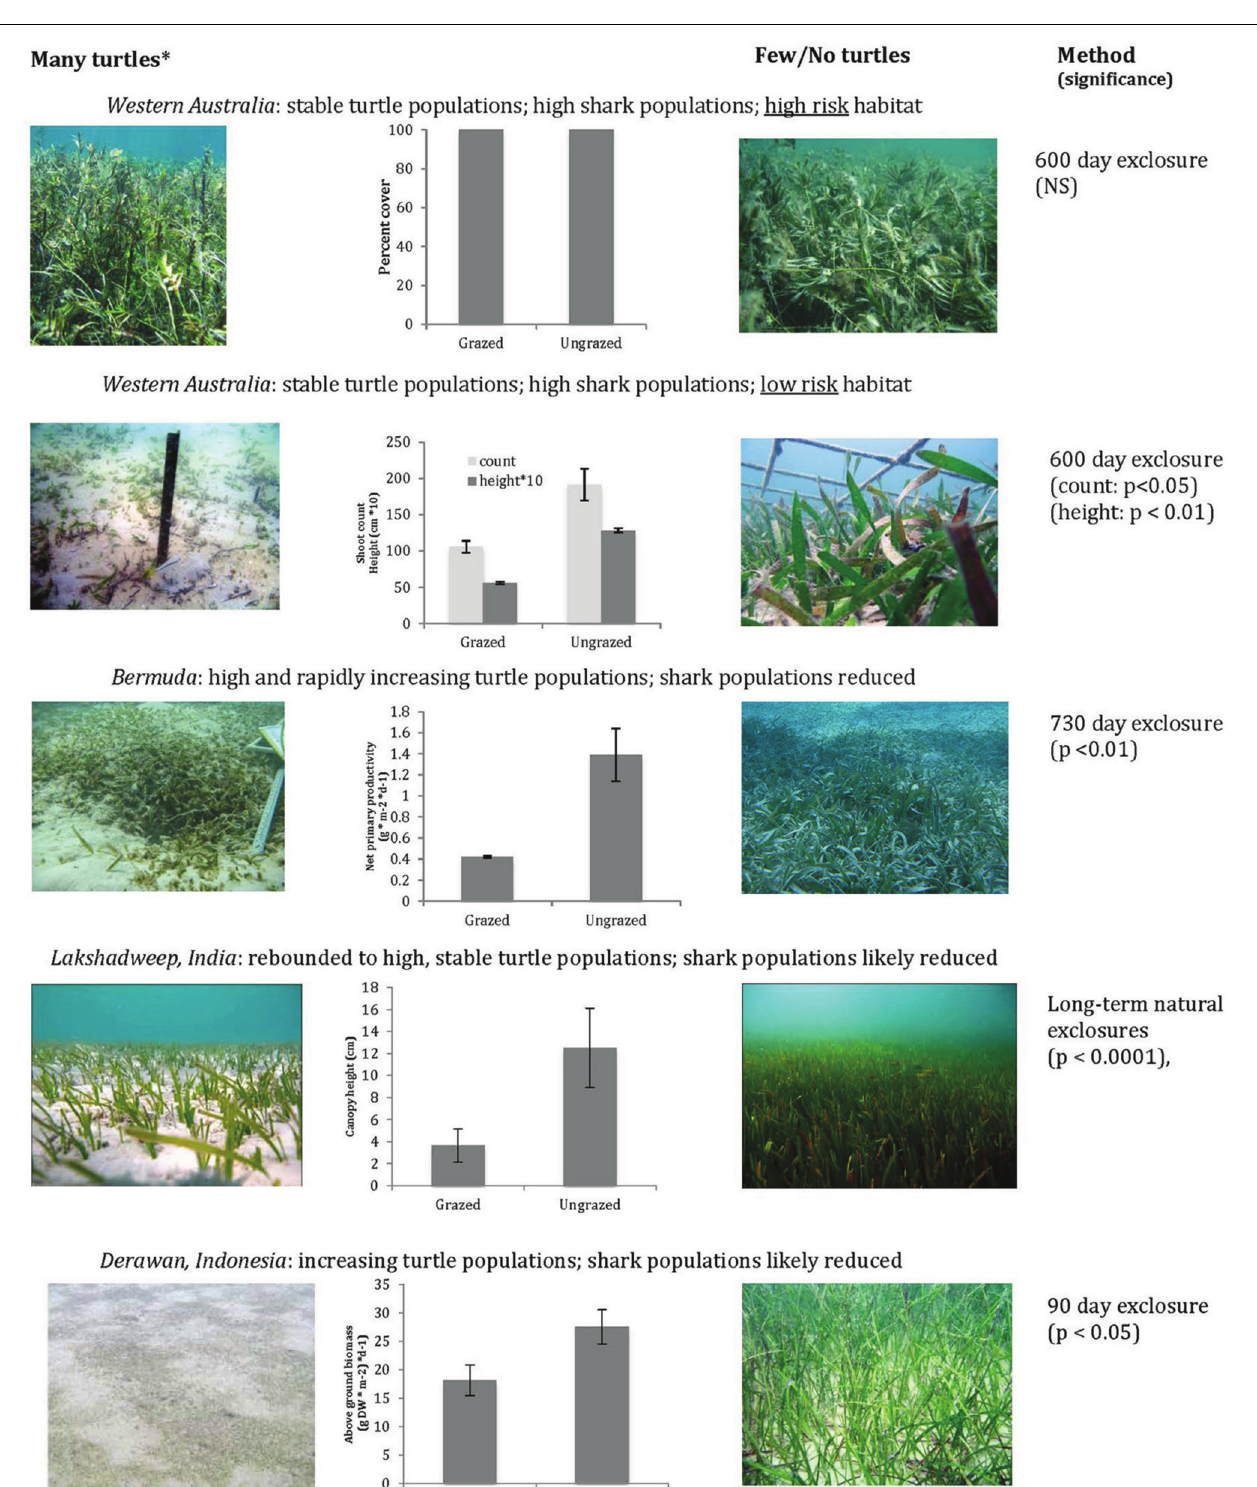
FIGURE 1 | Responses of seagrasses to green turtle grazing across ecological contexts. Although individual studies measured multiple responses of seagrasses, for simplicity we display selected results to demonstrate the diversity of seagrass responses to heavy turtle herbivory. In the Shark Bay experiments, high-risk habitats have been shown to have